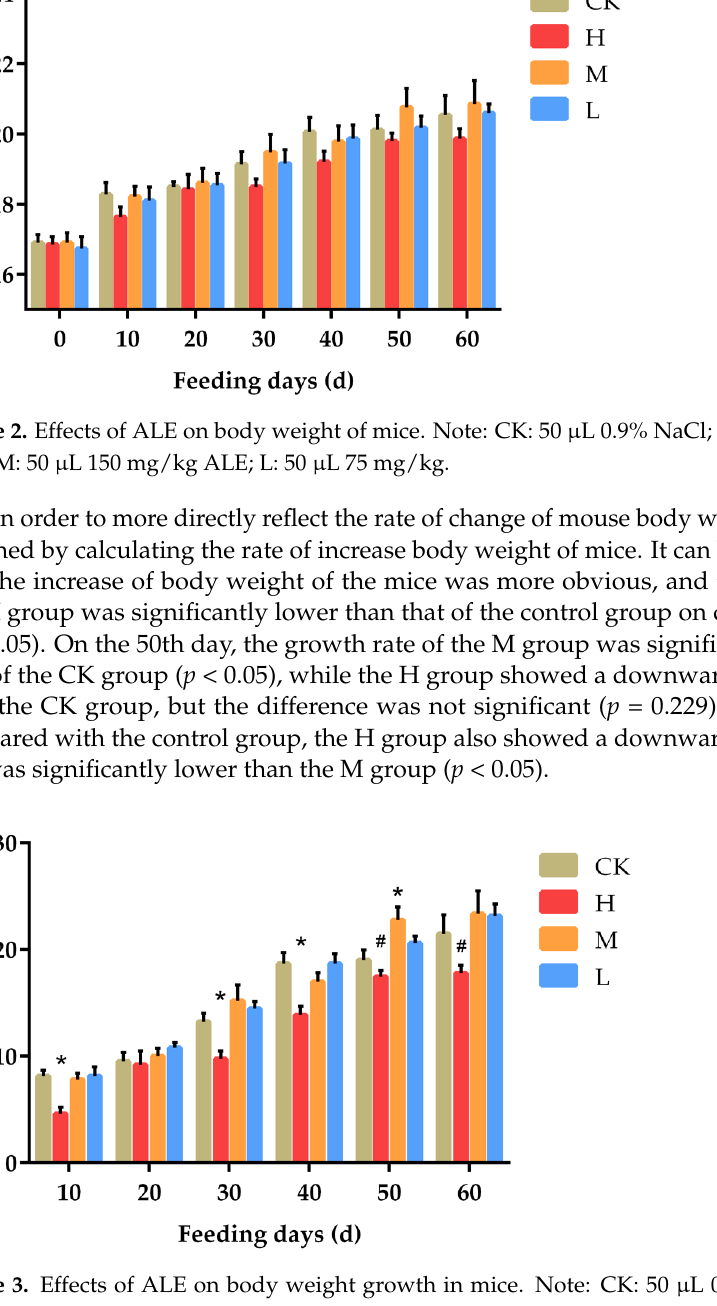
Figure 4. Effects of ALE on feed conversion rate in mice. Note : CK: 50 μL 0.9% NaCl; H: 50 μL 300 mg/kg ALE; M: 50 μL 150 mg/kg ALE; L: 50 μL 75 mg/kg. 3.2. Effects of ALE on Development in Mice The mice were weighed before being killed, and the hearts, livers, and spleens isolated from dissected mice were also weighed. It can be seen from Table 3 that the accurate weight of mice after one day of food and water deprivation, the average weight of mice in the M group was higher than that in the CK group, while the average weight of mice in the H group was the lowest, but the difference was not significant. There was no significant difference in the quality of other organs except the heart. Compared with the CK group, the heart quality of the M group was significantly higher than that of the CK group and the high-dose group ( p = 0.007), and the proportion of heart to body weight was significantly higher than that of the CK group ( p = 0.022). The spleen quality was the lowest in the H group and the highest in the M group, but the difference was not significant ( p = 0.075).